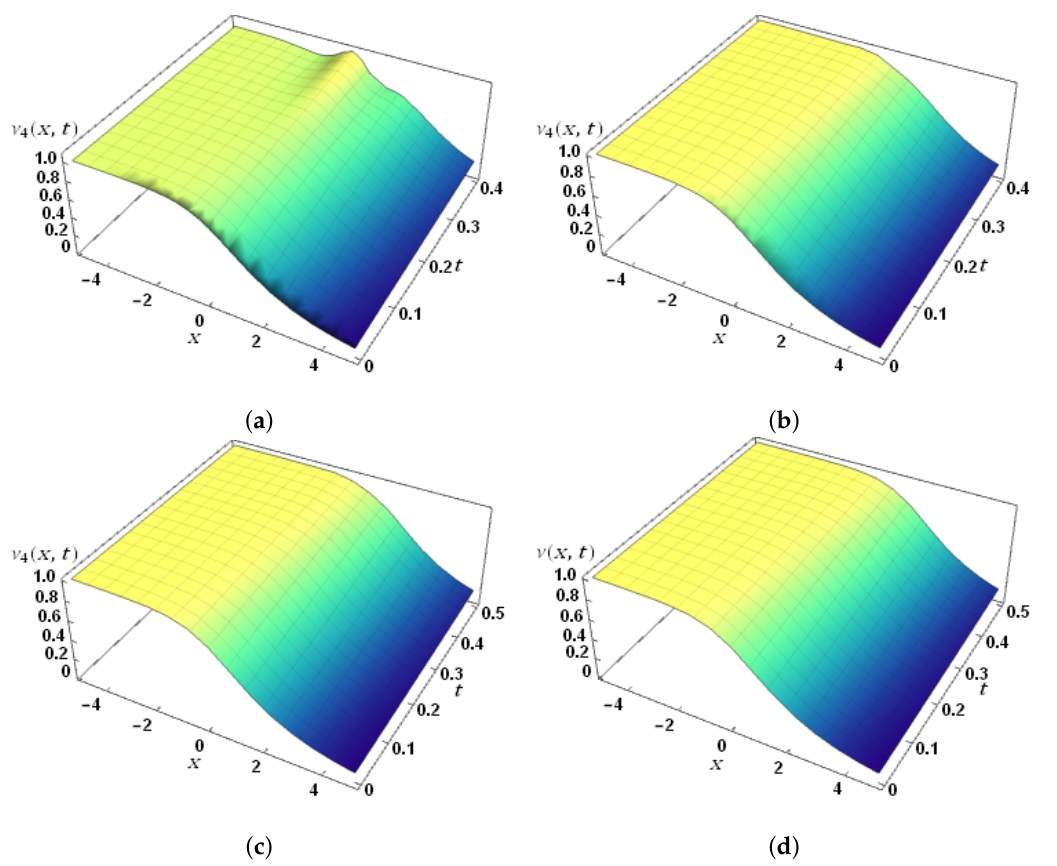
Figure 4. The surface graphs of the exact and ASs for Equations (55) and (56): ( a ) ν 4 ( x , t ) when α = 0.6, ( b ) ν 4 ( x , t ) when α = 0.8, ( c ) ν 4 ( x , t ) when α = 1, and ( d ) exact solution ( α =